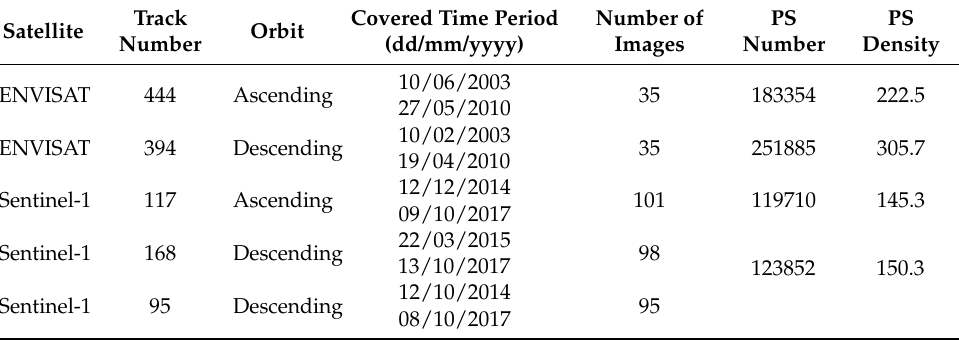
Table 1. Details of the available datasets of ENVISAT and Sentinel-1A and Sentinel-1B used to investigate the ground deformation in the Firenze–Prato–Pistoia